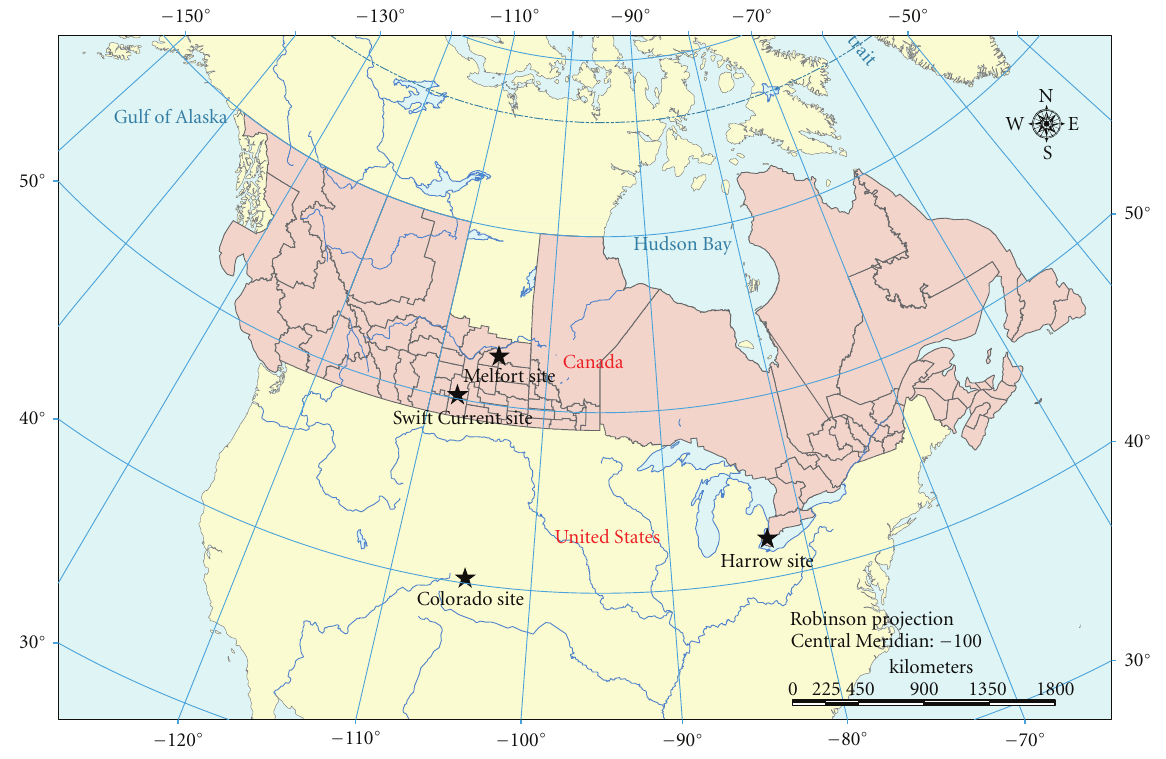
Figure 1: The location of the long-term agricultural experimental sites. The K¨oppen-Geiger climate classifications of the sites are as follows: Colorado, cold semiarid; Harrow, humid-continental; Melfort and Swift Current,